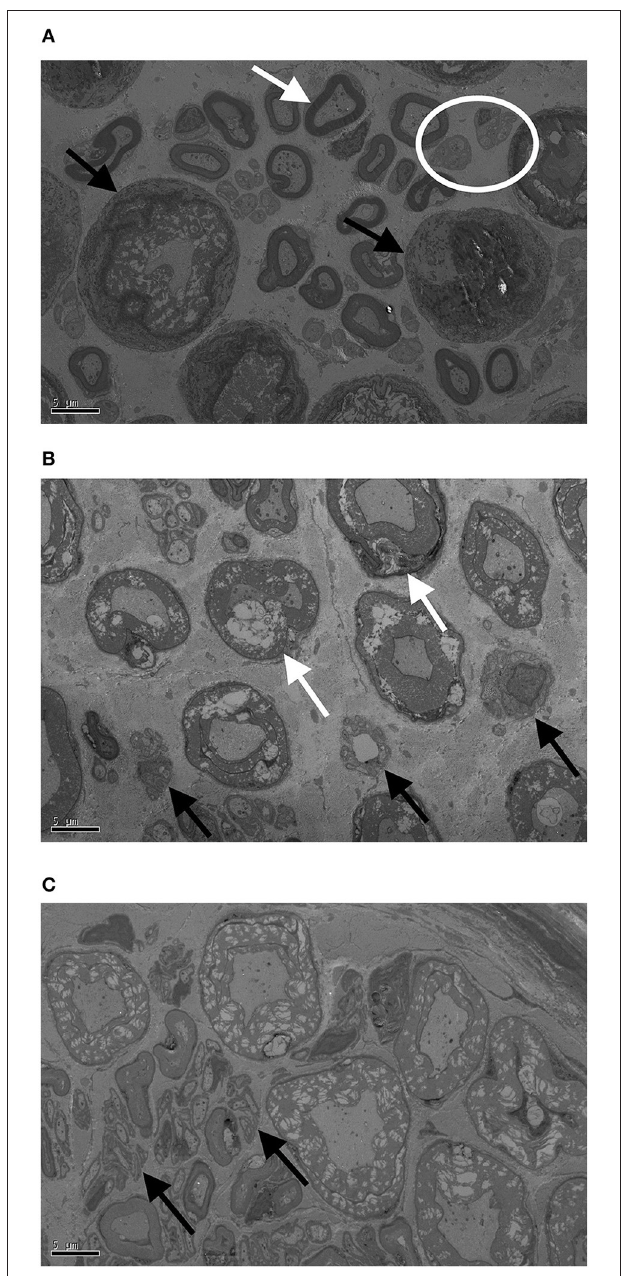
FIGURE 3 | Transmission electron microscopy (TEM) images of proximal ulnar (A) , distal radial (B) , and proximal radial (C) nerve samples. Bar represents 5 µ m. White arrow in (A) indicates healthy nerve fiber with Schwann cell, black arrows indicate entire fiber degeneration, and the white circle shows healthy Remak bundles (groups of unmyelinated fibers). In (B) white arrows show degenerating myelin while black arrows show degenerating Remak bundles. In (C) black arrow indicate denervated Schwann cell bands (unmyelinated axon loss).